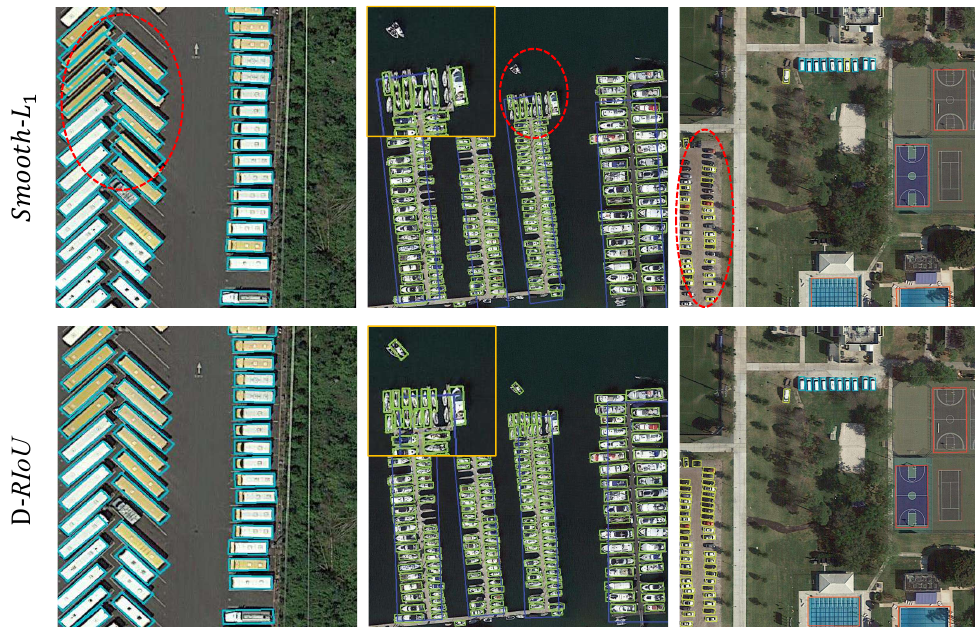
Figure 7. Detection results of models trained with different loss